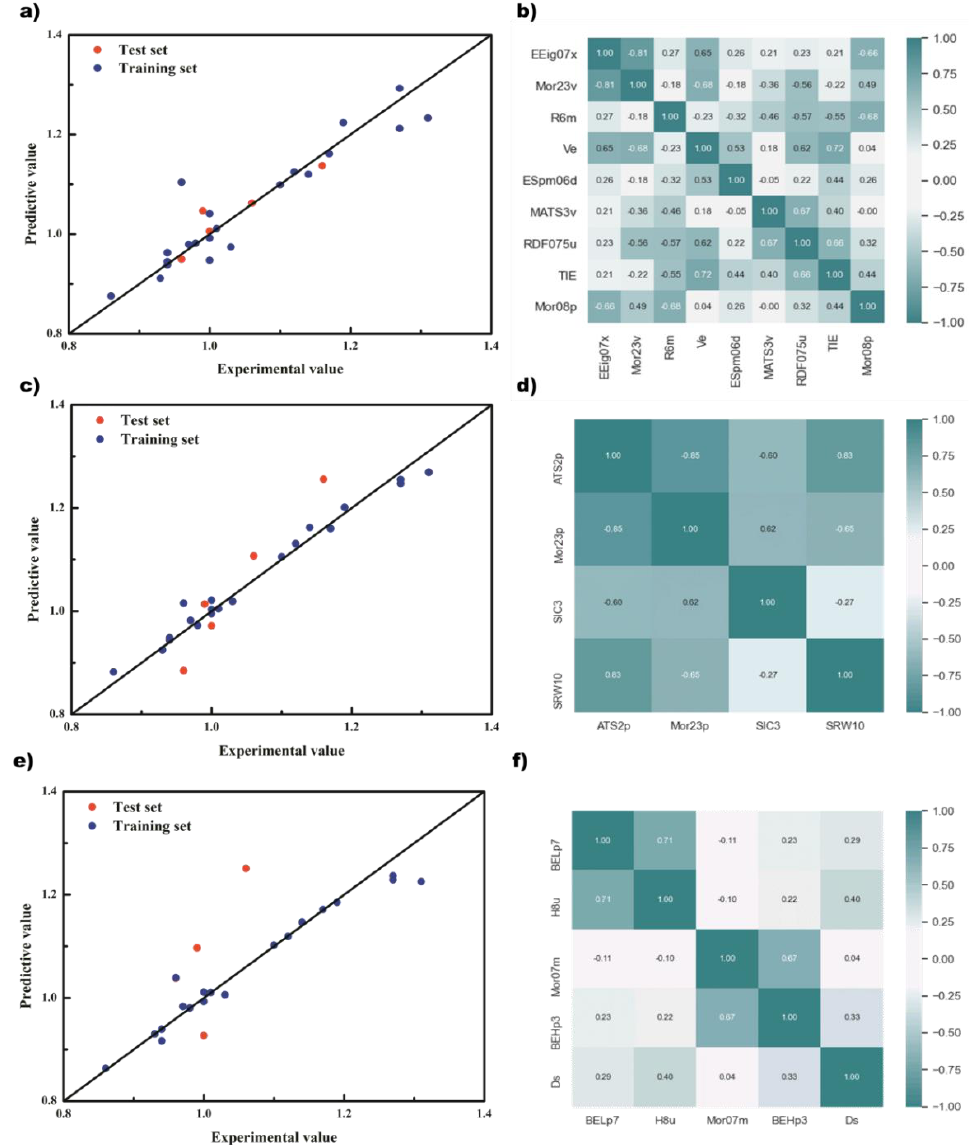
Figure 4. The prediction results of different regression models based on genetic algorithm and the correlation of descriptors. ( a ) And ( b ) PLS; ( c ) and ( d ) RF; ( e ) and ( f ) SVM. From the prediction results of the model, the points of the GA + PLS and GA + RF models were relatively evenly distributed on both sides of the standard line and relatively concentrated, and there was less obvious deviation from the standard line. However, there